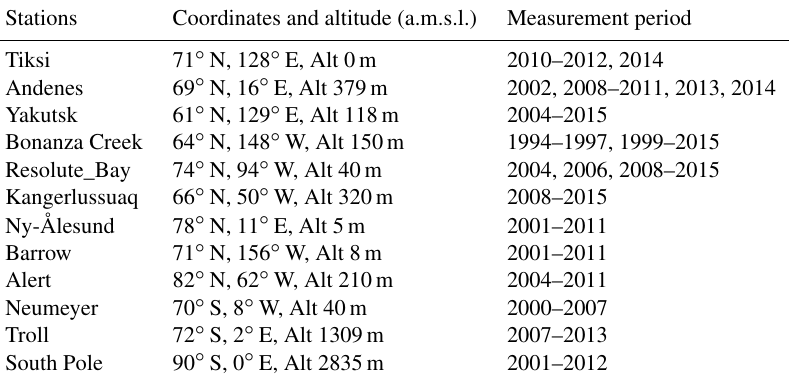
Table 2. List of the Arctic and Antarctic stations with ground-based measurements of AOD. Data for Tiksi, Andenes, Yakutsk, Bonanza Creek, Resolute Bay, and Kangerlussuaq are taken from the AERONET database (http://aeronet.gsfc.nasa.gov/) and data from Ny-Ålesund, Barrow, and Alert are from Stone et al. (2014) and Tomasi et al.